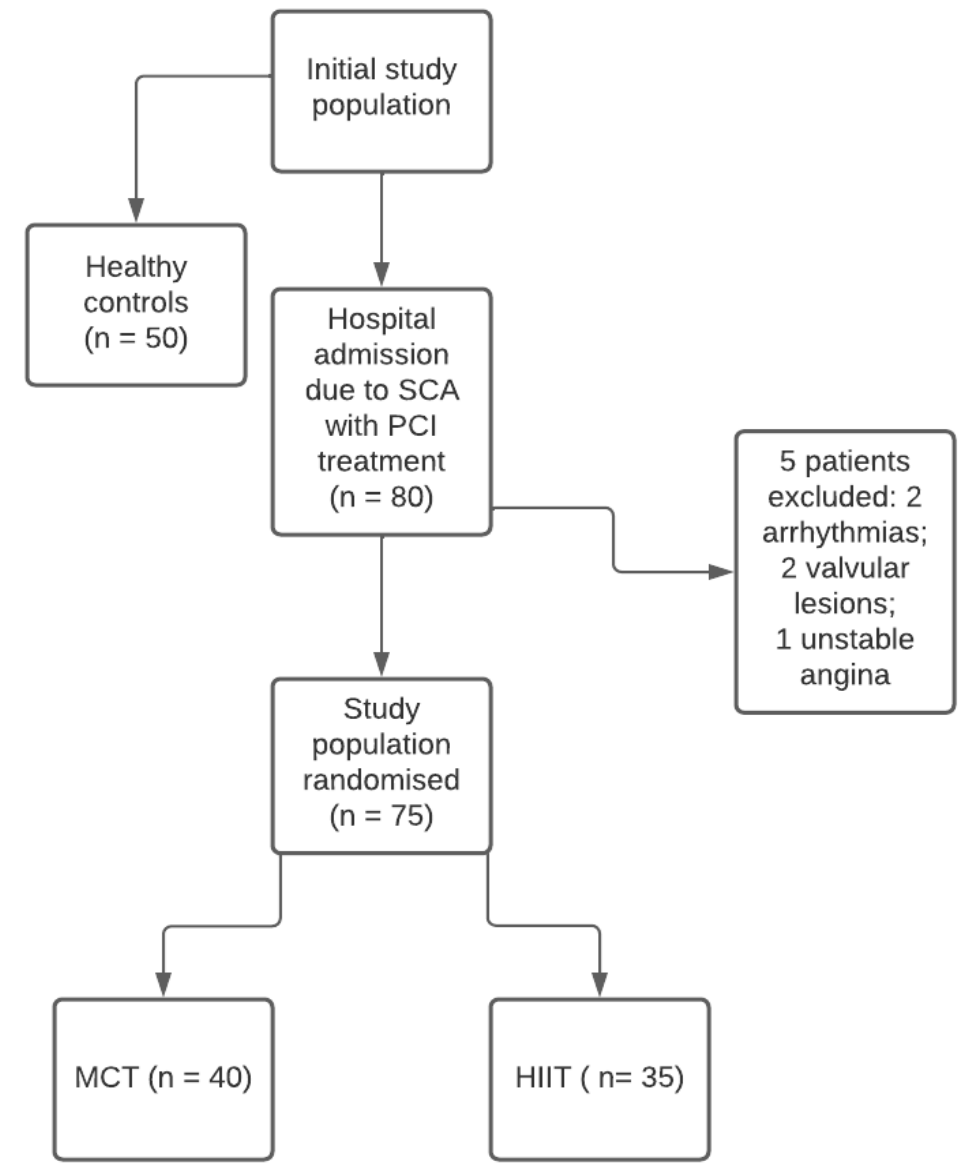
Figure 1. Flowchart. Diagram demonstrating the study protocol. ACS = acute coronary syn- Figure 1 . Flowchart. Diagram demonstrating the study protocol. ACS=acute coronary syndrome; PCI= Percutaneous Coronary Intervention; MCT= moderate-intensity continuous training; HIIT= drome; PCI = Percutaneous Coronary Intervention; MCT = moderate-intensity continuous training; high-intensity interval training. HIIT = high-intensity interval